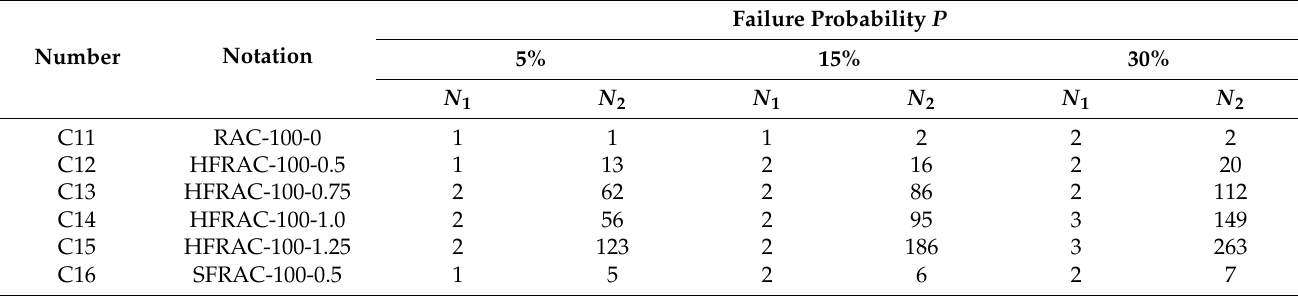
Table 6. Impact blows of FRAC for different probabilities of